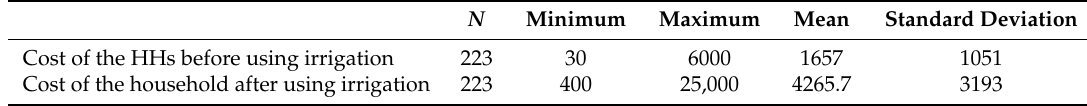
Table 6. Annual average costs of HHs before and after irrigation in ETB. N Cost of the household after using